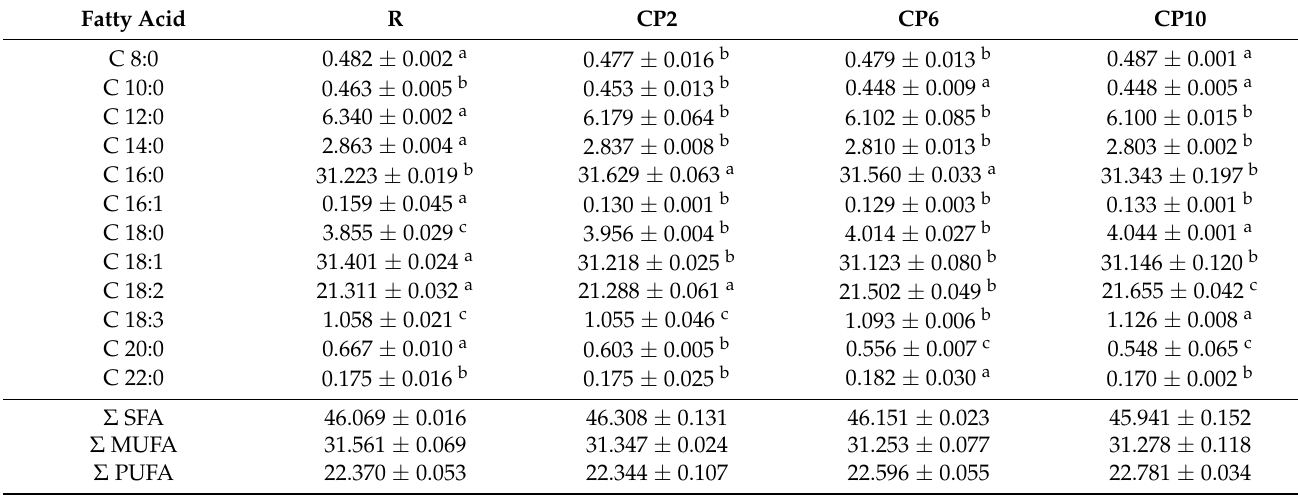
Table 4. Fatty acid composition of biscuits enriched with CP (as a percentage of total fatty